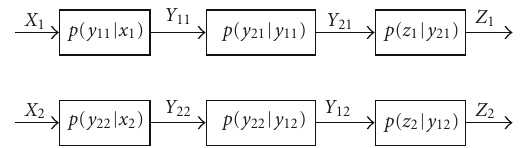
Figure 4: The parallel degraded multireceiver wiretap